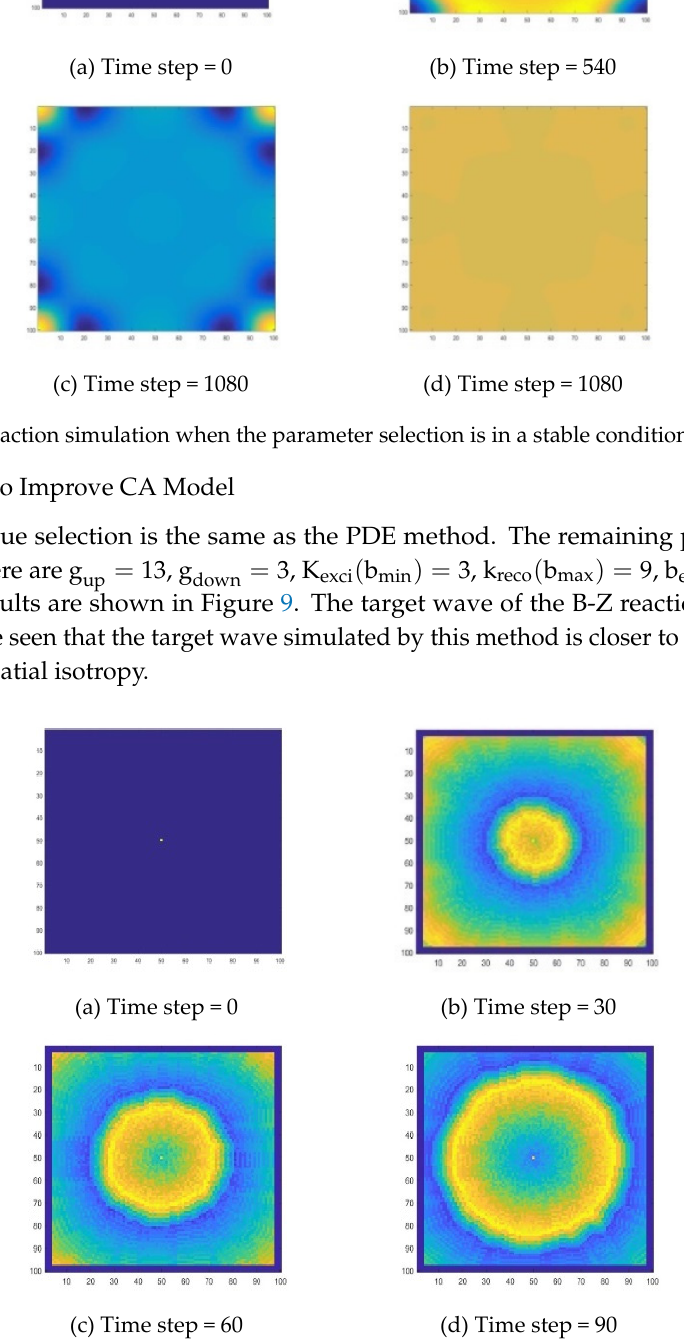
Figure 9. Propagation of target travel waves simulated by B-Z reaction using cellular automata (CA).